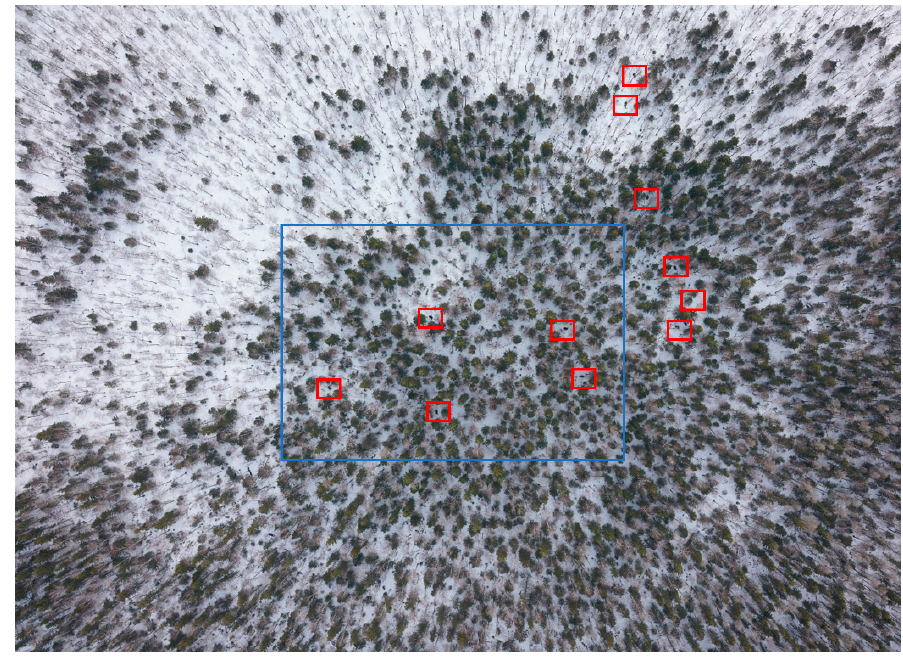
Figure 6. RGB image of Group 2.